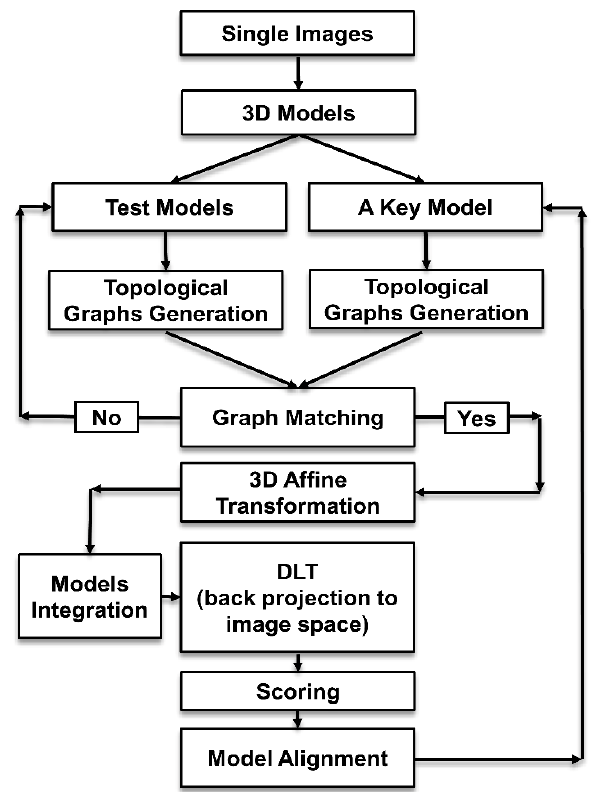
Figure 3. The workflow of the proposed image-based model alignment